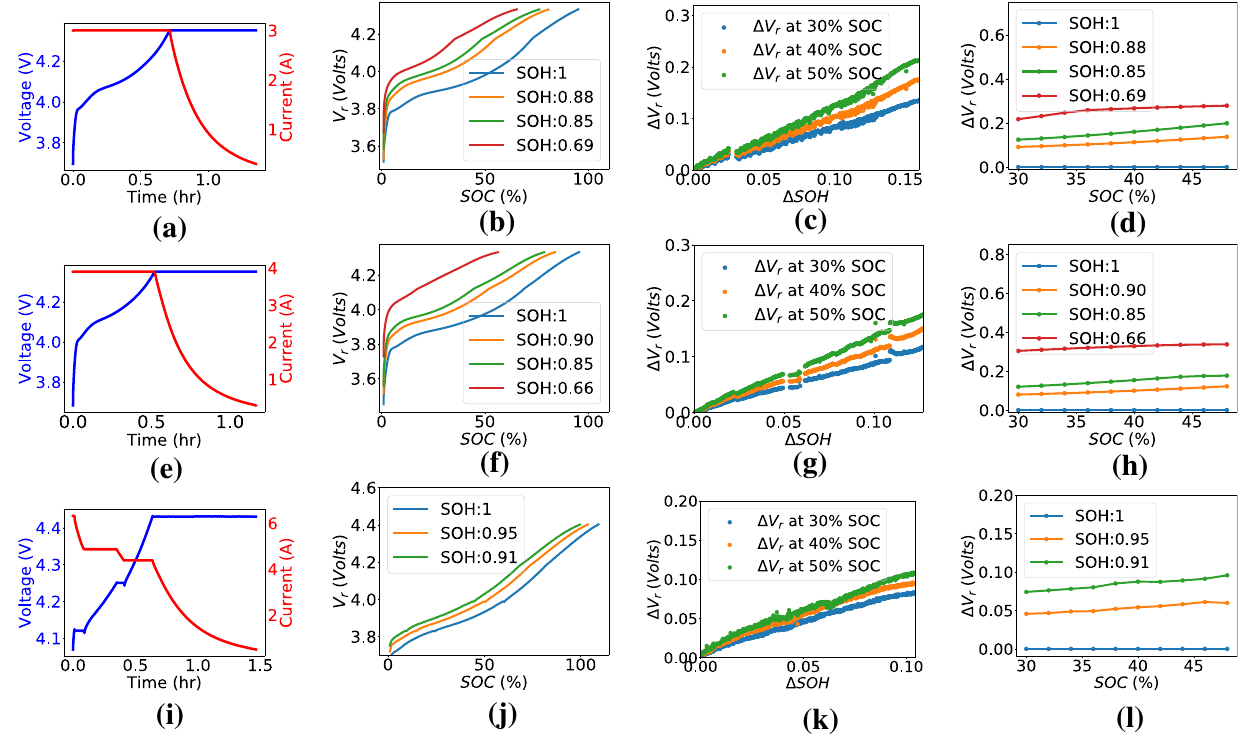
Figure 2. ( a ), ( e ), ( i ) Voltage current plots for charge profile 1C-CCCV, 1.3C-CCCV, 1C-MSCCCV respectively. ( b ), ( f ), ( j ) V r at different SOH values for charge profiles in ( a ), ( e ), ( i ) respectively. ( c ), ( g ), ( k ) Correlation between (cid:31) V r and (cid:31) SOH for plots in ( b ), ( f ), ( j ) at 3 different SOC points. ( d ), ( h ), ( l ) A set of features computed from the plots in ( b ), ( f ), ( j )